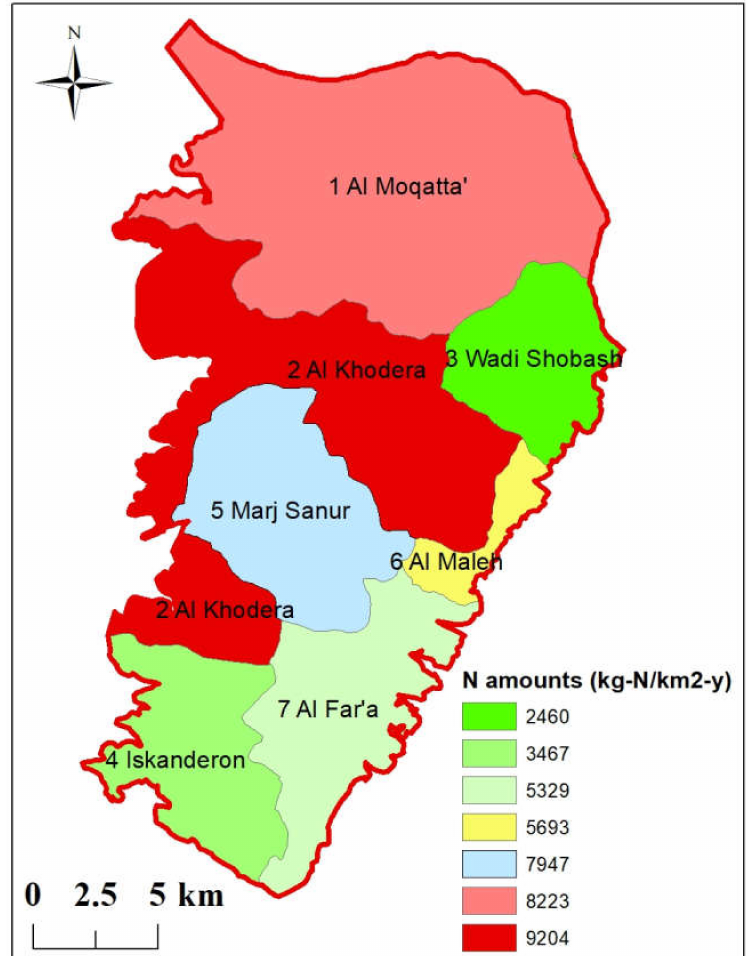
Figure 8. Annual total nitrogen for each watershed intersecting the area of the Eocene